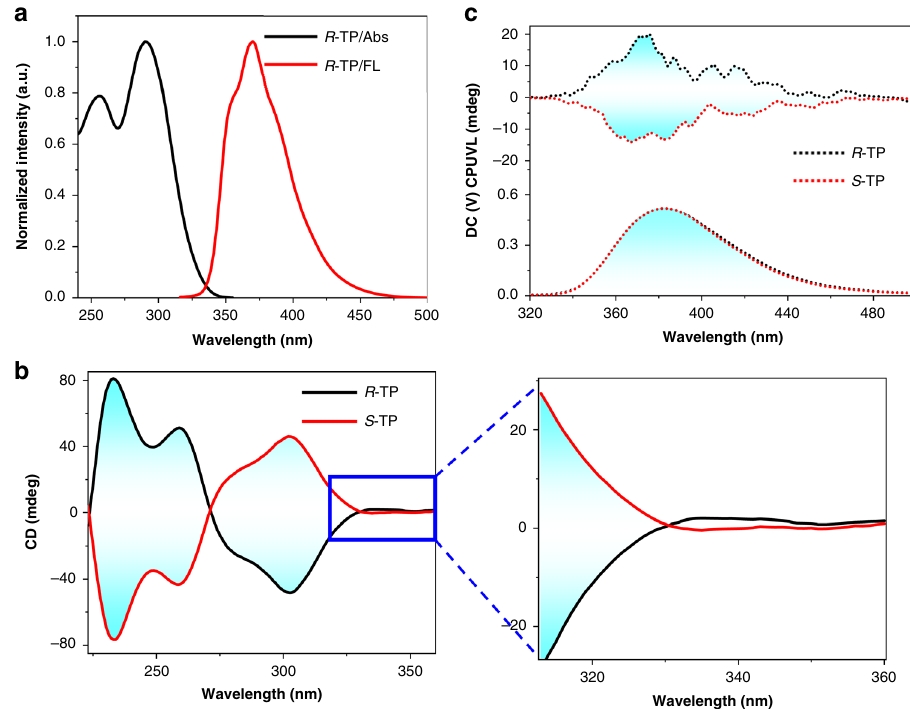
Fig. 2 CD and CPUVL spectra of R -/ S -TP in THF solution. a Normalized absorption and emission spectra of R -TP (0.01 mM, λ ex = 290 nm) in THF solution. b CD spectra of R ( S )-TP in THF solution ([ R- TP] = [ S -TP] = 0.01 mM). c CPL spectra of R ( S )-TP in THF solution ([ R -TP] = [ S -TP] = 0.01 mM, λ = 290 ex